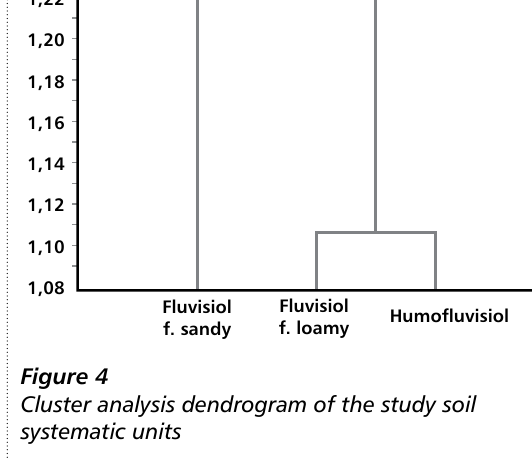
Figure 4 Cluster analysis dendrogram of the study soil systematic units